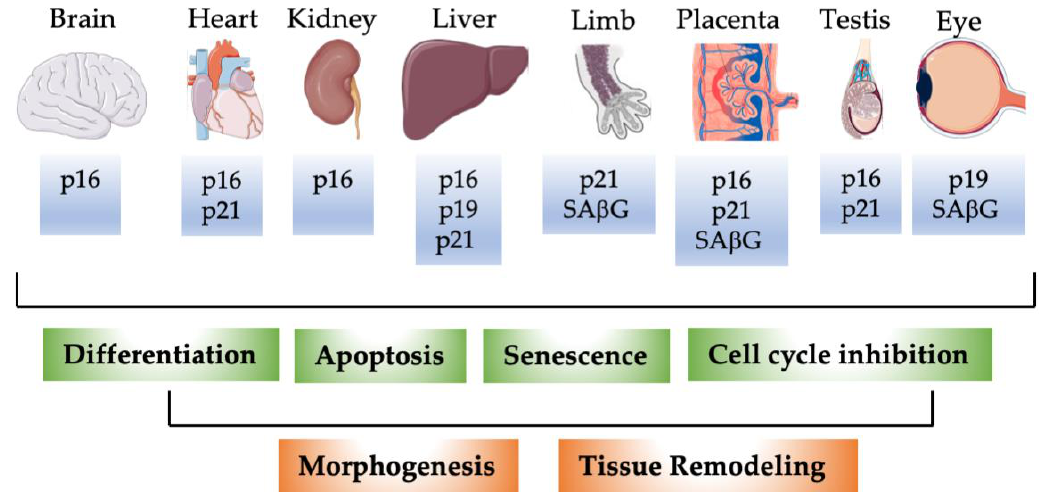
Figure 1. Schematic illustration of detection of p16INK4A, p14ARF/p19ARF, p21, and SAβG in selected murine organs during development. P16: p16INK4A; p19: p14ARF/p19ARF. During development, p16INK4A, p14ARF/p19ARF, p21, and SAβG not only mark senescent cells. p16INK4A, p14ARF/p19ARF, and p21 proteins are expressed in distinct cell types during different developmental stages. Expression of the individual proteins correlates with lower expression of proliferation markers in agreement with their classical function as cell cycle inhibitors, with apoptosis, and cellular differentiation. These fundamental processes contribute dynamically to tissue remodeling and morphogenesis during embryonic development.